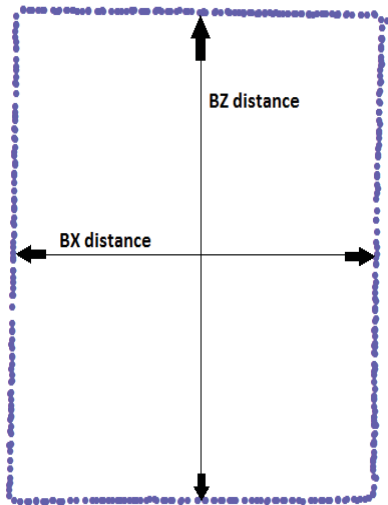
Figure 3. An example of a point section extracted from the point clouds for the B section. Arrows indicate the distances to be